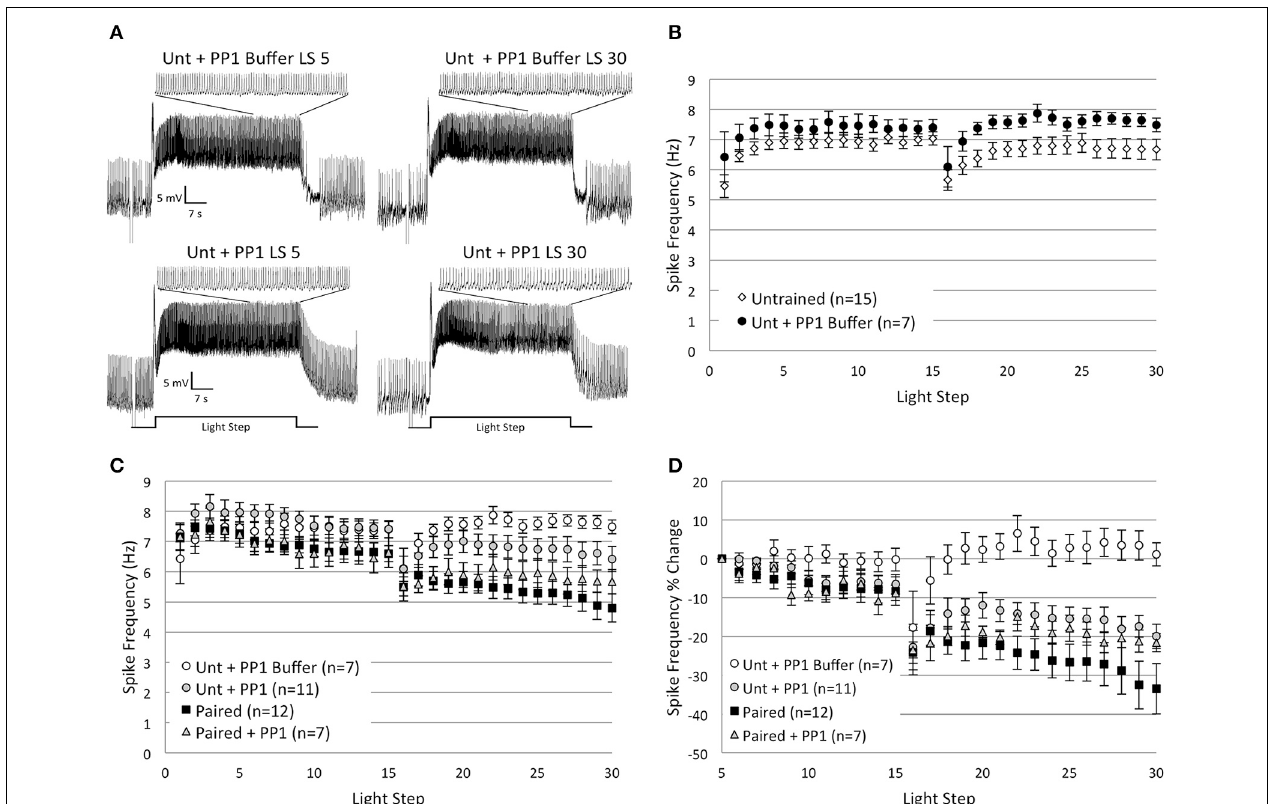
FIGURE 5 | Injection of catalytically active protein phosphatase 1 (caPP1) reduced spike frequencies in Untrained cells by the 30th LS and occluded any additional spike frequency reductions in Paired cells. (A) Representative light responses recorded from an Untrained B cell injected with PP1 buffer ( Unt + PP1 Buffer ; top trace) or caPP1 ( Unt + PP1 ; bottom trace). The Unt + PP1 Buffer control cell showed a slight increase in spike frequency from the 5th to 30th LS, while the Unt + PP1 cell showed a progressive 23% decrease in spike frequency that mimicked the decreases observed in Paired (no drug) cells, i.e., in vitro extinction. Inset traces show last 10s of LS. (B) Summary spike frequency data for Untrained and Untrained + PP1 Buffer control cells across 30 LSs. Note the slight excitatory effect of the buffer. (C) Summary spike frequency data for 30 successive LSs indicated that Unt + PP1 cells showed qualitatively lower spike frequencies during LSs 16–30 compared to Unt + PP1 Buffer and Untrained controls, and were no different than Paired (no drug) cells, thereby producing spike frequency reductions similar to those observed during in vitro extinction.